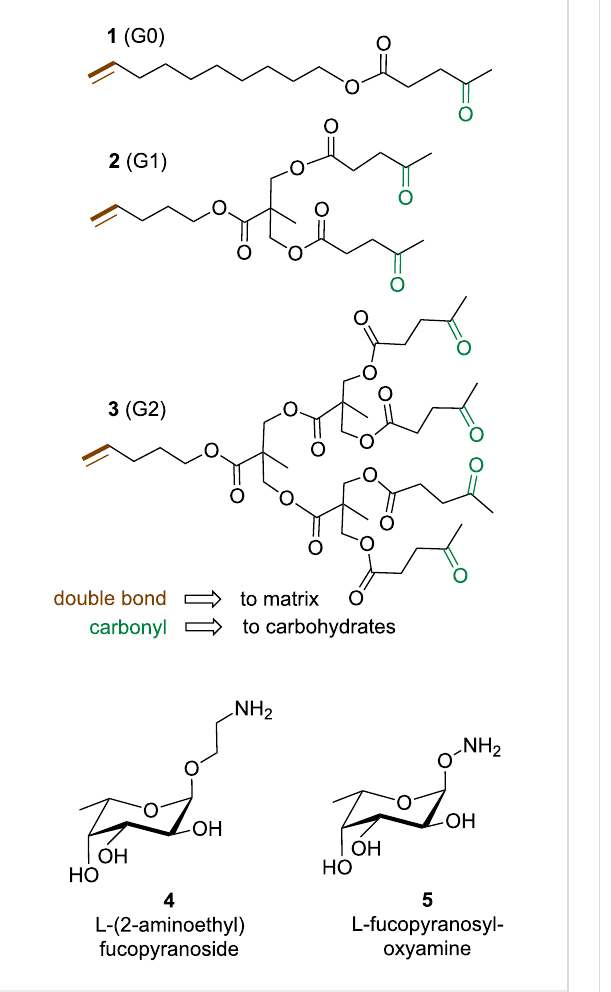
Figure 1: Synthesized G0, G1 and G2 dendrons and functionalized saccharides used for carbonyl